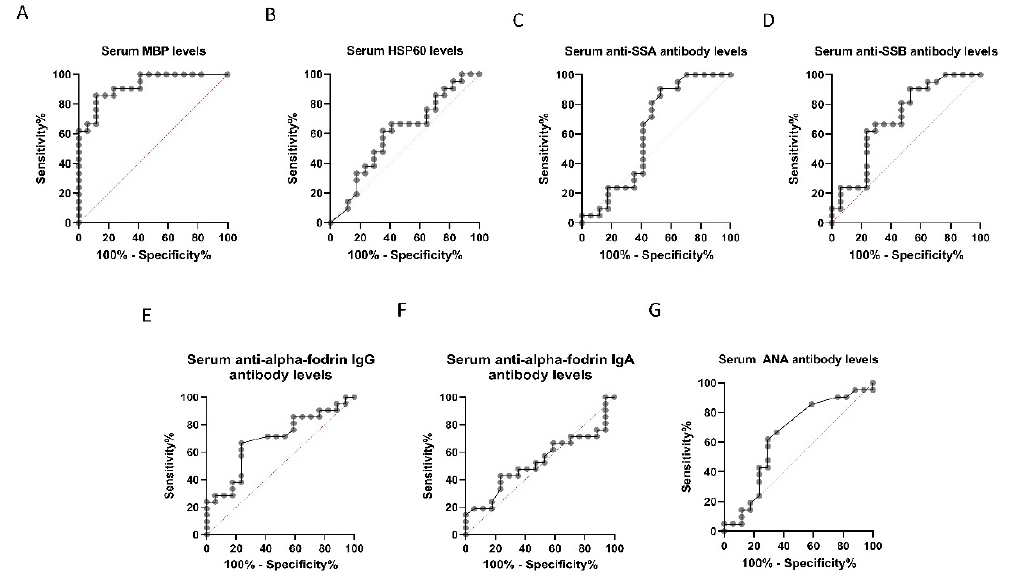
Figure 3. Receiver operating characteristic (ROC) curve analysis for discrimination between control participants and patients with glaucoma. ROC curves for the serum levels of myelin basic protein (MBP) ( A ), heat shock protein 60 (HSP60) ( B ), anti-Sjögren’s-syndrome-related antigen A (SSA) antibody ( C ), anti-Sjögren’s-syndrome-related antigen B (SSB) antibody ( D ), anti- α -fodrin IgG/IgA antibody ( E , F ), and anti-nucleic acid (ANA) antibody ( G ) are shown. The area under the curve for serum MBP concentration was the largest.